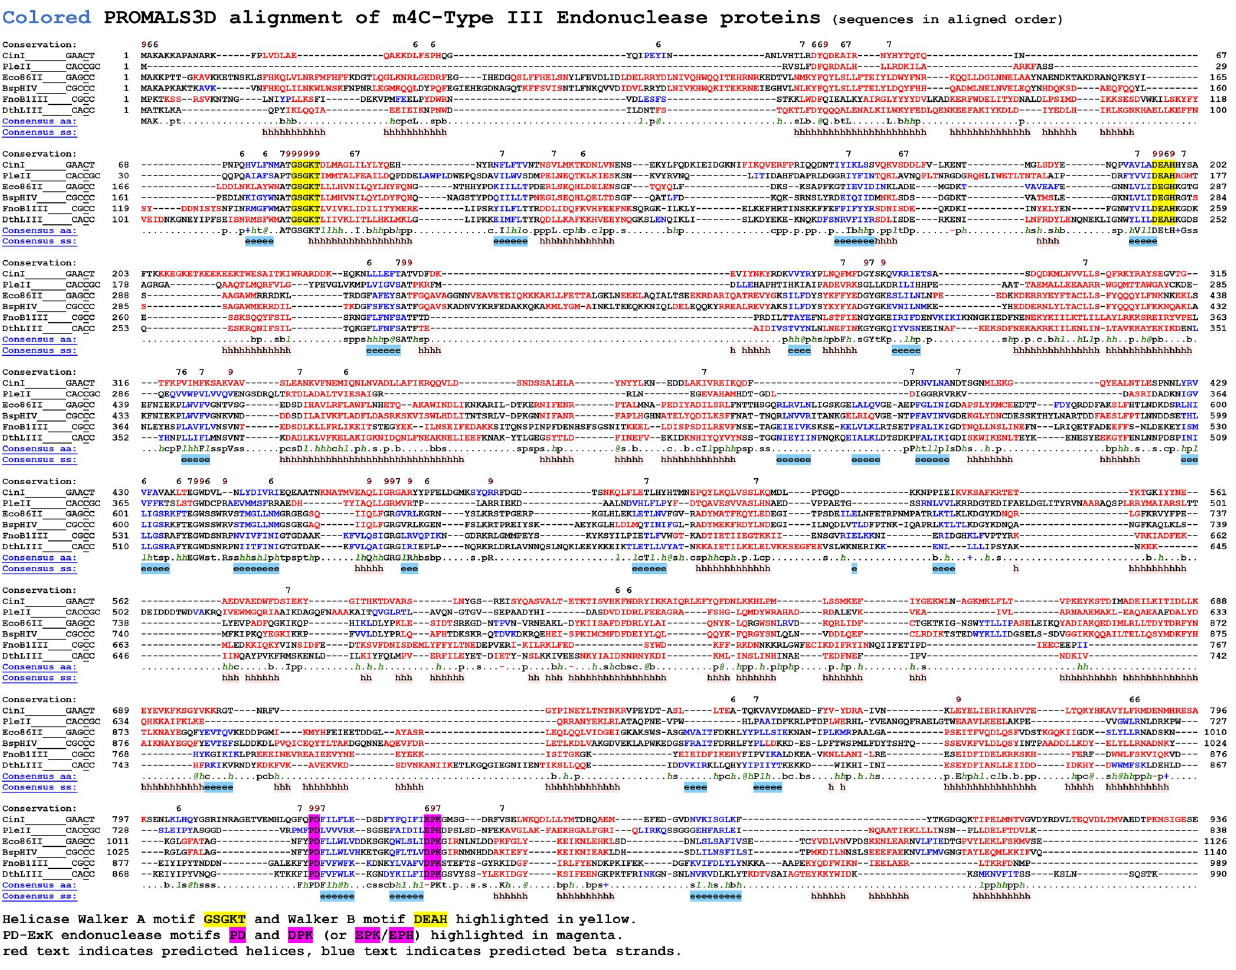
Fig 3. Alignment of the six characterized Type III endonucleases. The Res subunit of each system contains a conserved Walker A (GSGKT) and Walker B DEAD-BOX/DEXH motif typically associated with ATP-dependent DNA helicase proteins, and a canonical PD-(D/E)XK endonuclease catalytic motif located toward the carboxy